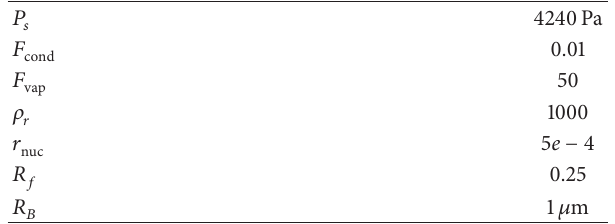
Table 3: Variables used in Rayleigh-Plesset’s cavitation